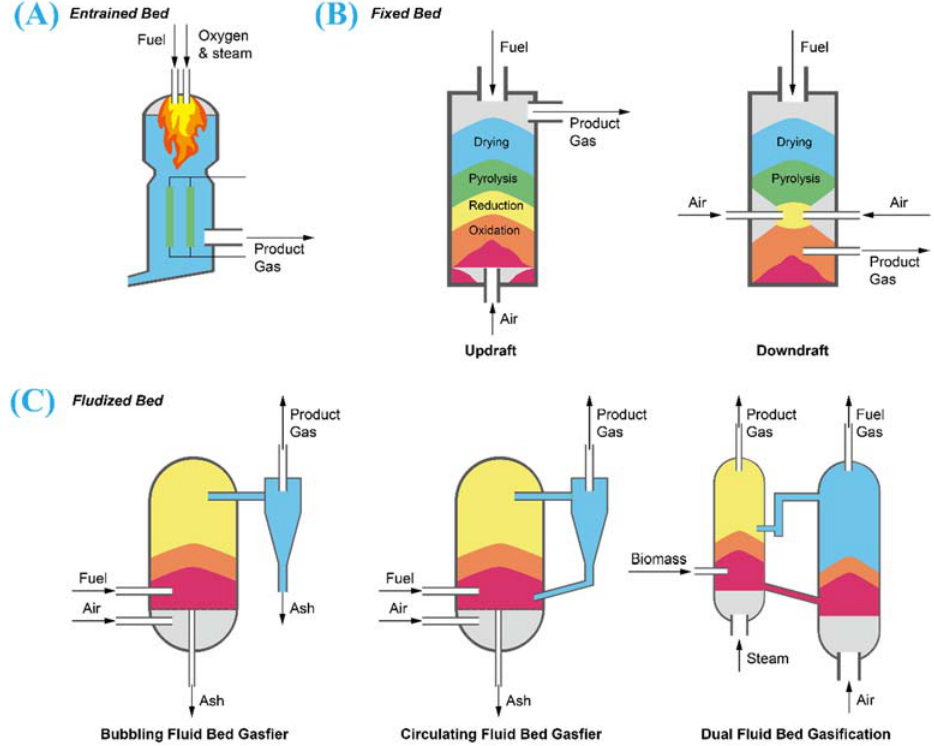
Figure 3. Schematic illustration of different types of gasifiers: ( A ) entrained flow, ( B ) fixed bed (left: updraft and right: downdraft) and ( C ) Fluidized bed (left: bubbling fluidized bed, middle: circulating fluidized bed and right: dual fluidized bed). Table 2. Comparison of different types of gasifiers for biomass gasification including their operational conditions, ad ‐ vantages and limitations.